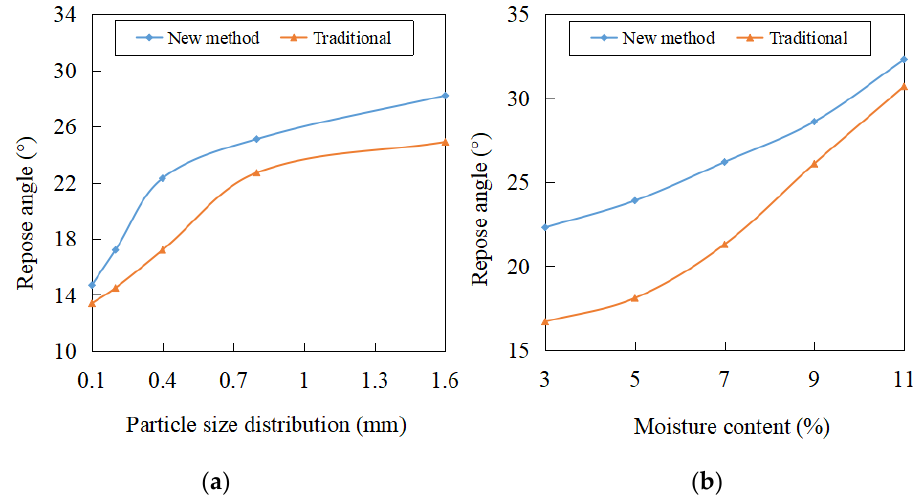
Figure 13. Influence of coking coal characteristics on repose angle. ( a ) The effect of particle size distribution on the repose angle; ( b ) The effect of moisture content on the repose angle In Figure 13a, the effect of particle size distribution on the repose angle can be seen.